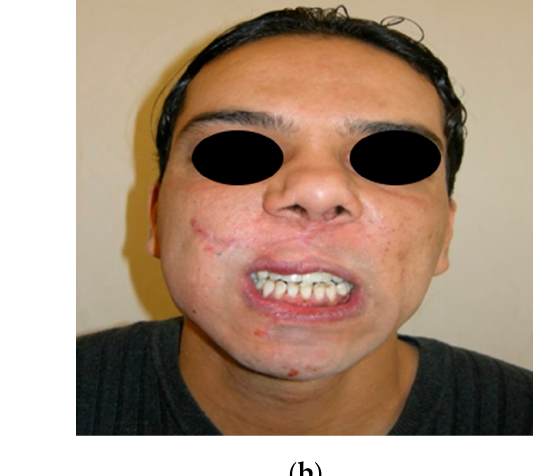
Figure 4. A 29-year-old male patient wounded by a high-velocity injury weapon. ( a ) Before prosthetic treatment; ( b ) after prosthetic treatment.